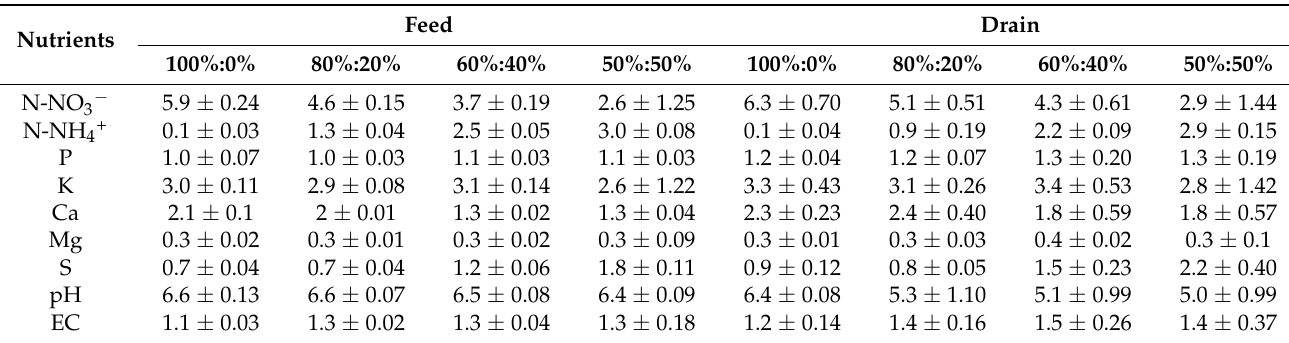
Table 2. Feed and drain of four fertilizer treatments. The concentration of each nutrient is presented in mmoL/L. The EC is presented in dS/cm. Data is presented as the mean ± standard deviation ( n =